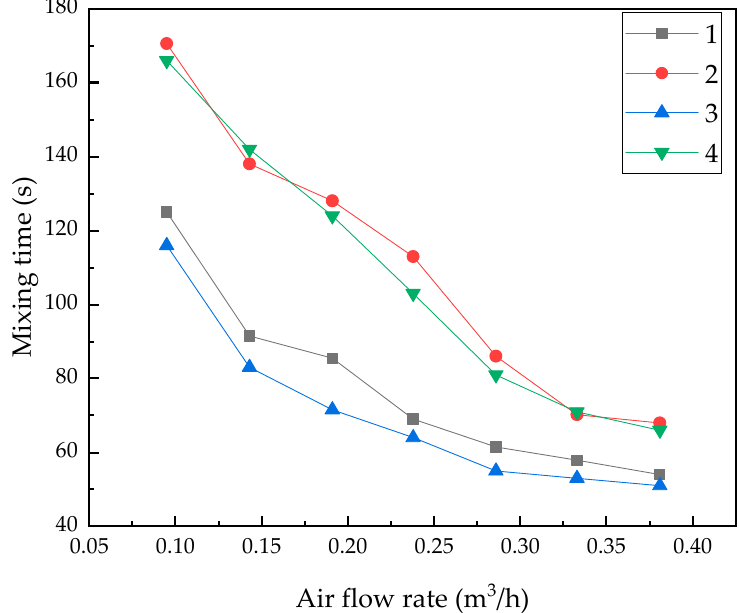
Figure 3. The relation between mixing time and air flow rate in the ladle with single porous plug and double porous plugs: ( 1 ) Single porous plug without oil layer; ( 2 ) single porous plug with 16 mm OLT; ( 3 ) double porous plugs without oil layer; ( 4 ) double porous plugs with 16 mm OLT.